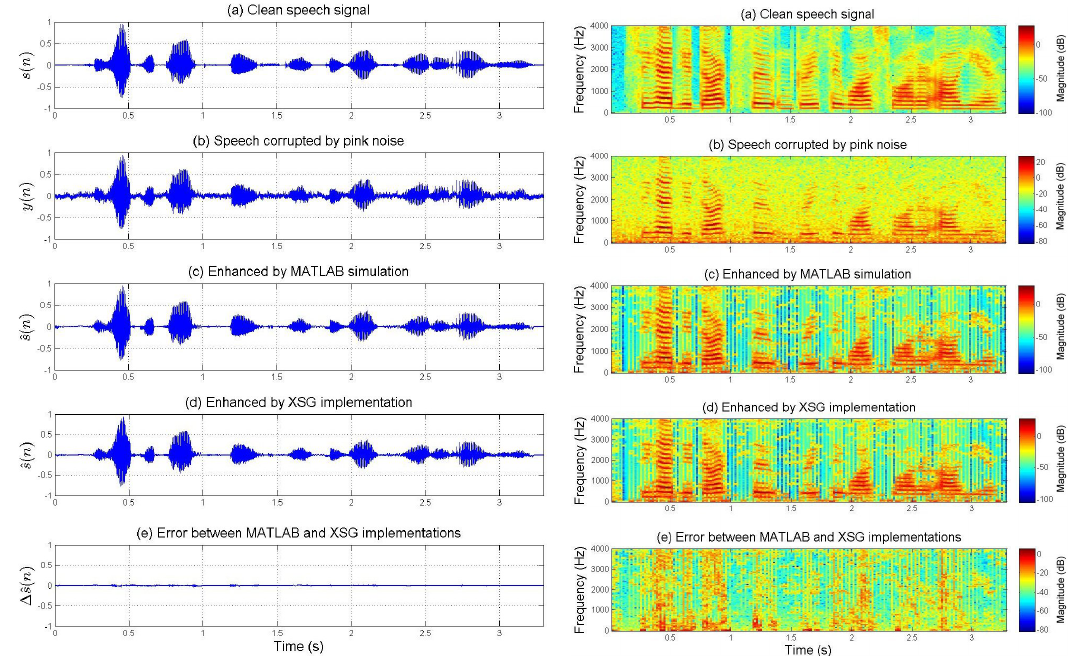
Figure 5. As in Figure 4 but for pink noise.